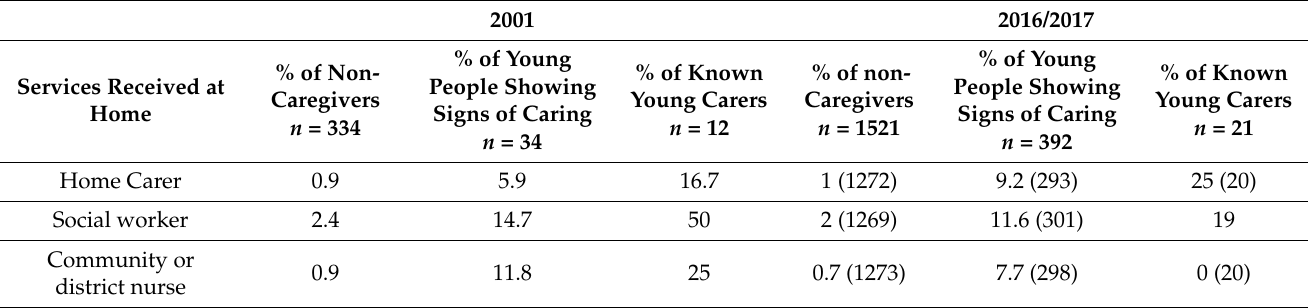
Table 9. Nature of support services received by non-caregiver, young people showing signs of caring and young carer households in 2001 and 2016/17.